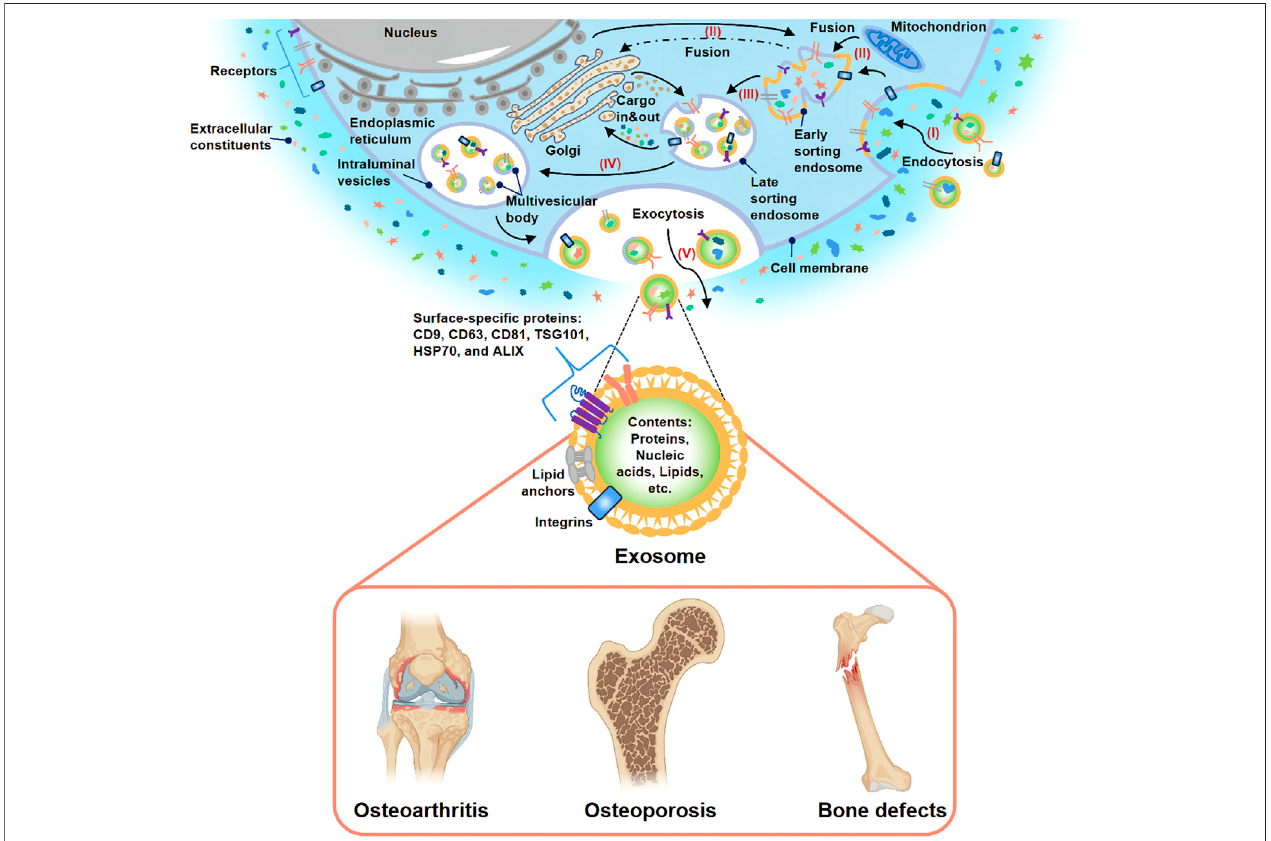
FIGURE1| Biogenesis,secretion,andpotentialapplicationofexosome.(I)Extracellularconstituentsandcellsurfaceproteinsenteredcellsthroughendocytosis.(II) The formation ofthe cell membrane budded in the luminal side. The fusion ofthe bud with the compositions ofthe endoplasmic reticulum, Golgi, and mitochondria gave risetoearlysortingendosomeformation.(III)Then,earlysortingendosomeledtolatesortingendosome.(IV)Thesecondaryinvaginationwasmodi fi edwithcargos,giving rise to the generation of various intraluminal vesicles and the formation of the multivesicular body. (V) At last, the exocytosis of the multivesicular body released intraluminalvesiclestotheoutsideofcellsintheformofexosomes.Manystudieshavedemonstratedthatexosome-basedtreatmentwaseffectiveforOA,OP,andbone defects.